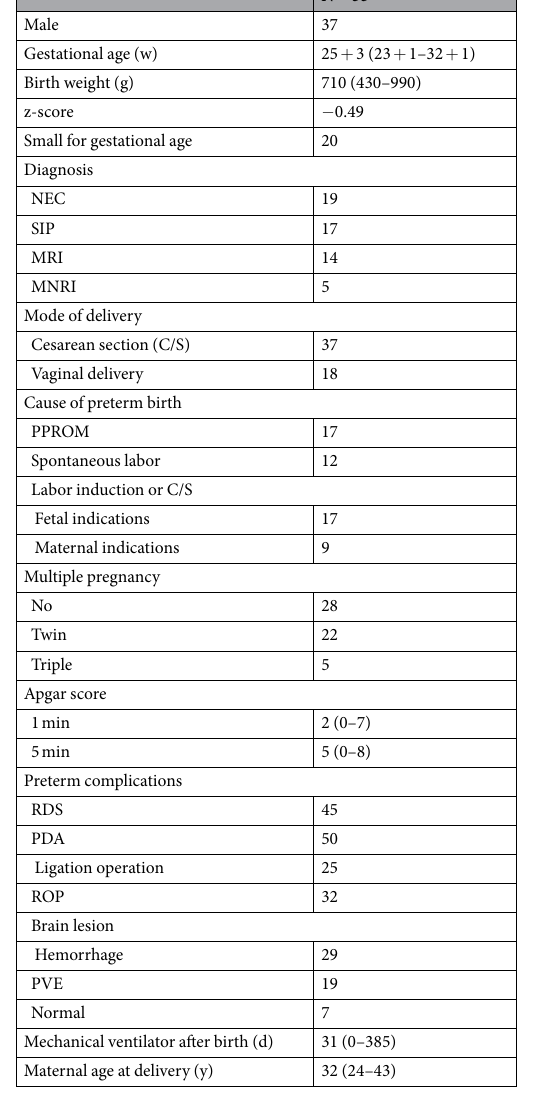
Table 2. Patients’ characteristics. NEC: necrotizing enterocolitis, SIP: spontaneous intestinal perforation, MRI: meconium-related ileus, MNRI: meconium non-related ileus, PPROM: preterm premature rupture of membrane, RDS: respiratory distress syndrome, PDA: patent ductus arteriosus, ROP: retinopathy of prematurity, PVE: periventricular